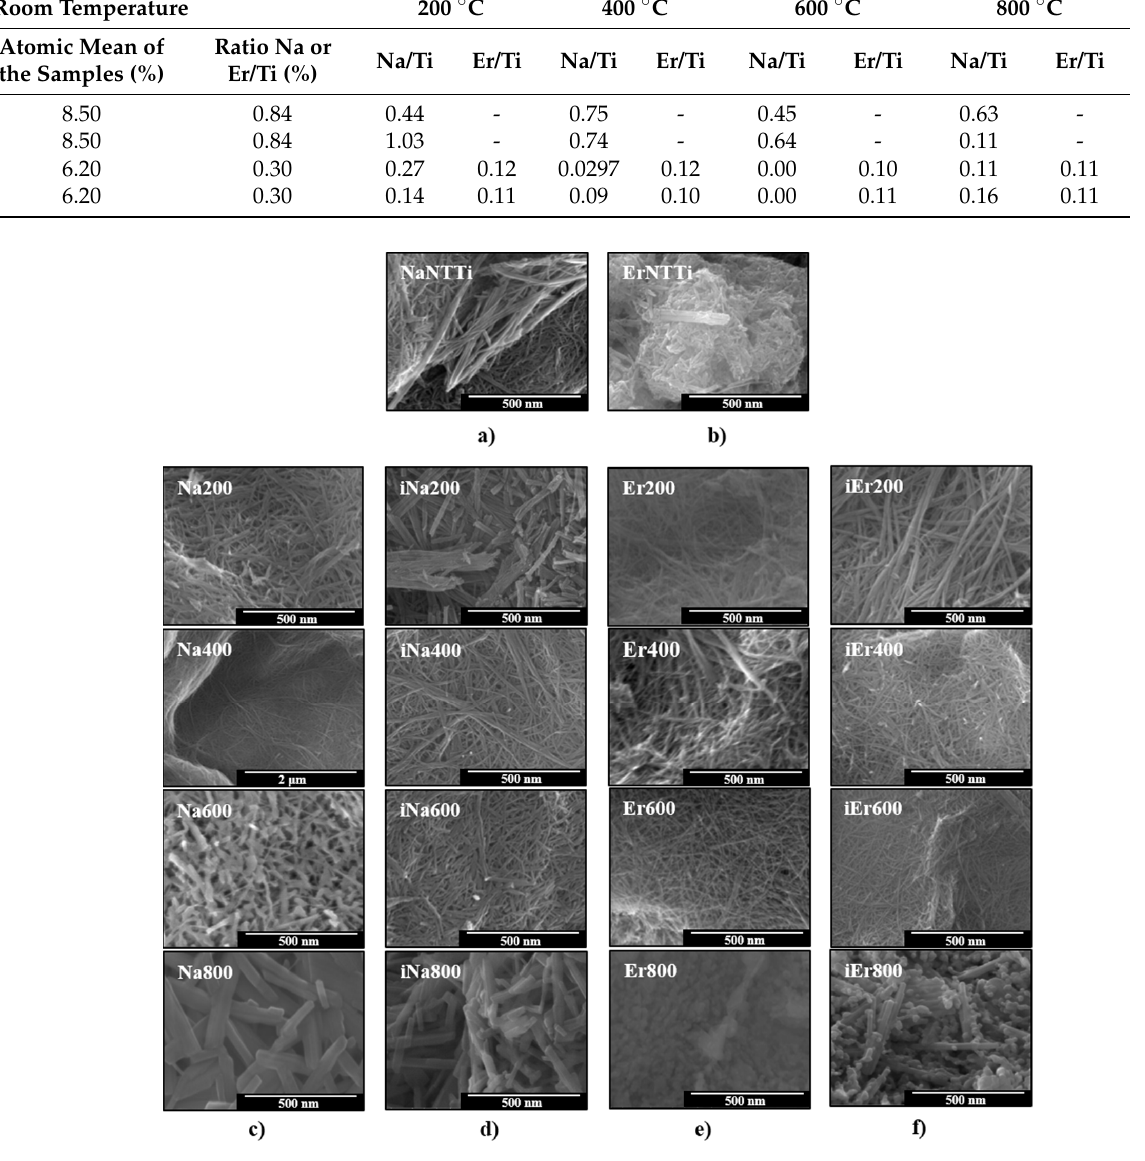
Figure 3. SEM images of ( a ) NaTiNTs and ( b ) ErTiNTs heat treated in air and argon atmosphere. In ( c ) and ( d ), the fibrillar morphology of NaTiNTs is preserved with increasing temperature but with a different aspect in 800 °C, indicating the probable formation of hexatitanate nanorods (Na 2 Ti 6 O 13 ). In ( e ) and ( f ), the fibrillar morphology of ErTiNTs is preserved up to 600 °C and clusters of NPs anatase are formed at 800 °C. The prefix “i” in columns ( d ) and ( f ) indicates the samples treated in inert atmosphere (argon).